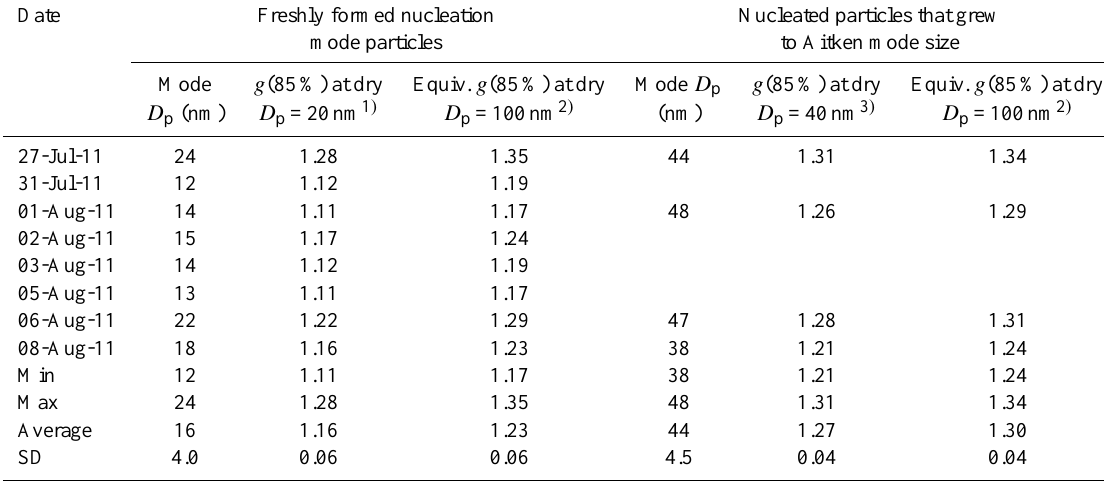
Table 1. Mode D p and g (85%) values of freshly formed nucleation mode particles and nucleated particles that grew to Aitken mode size at the Sapporo study site.